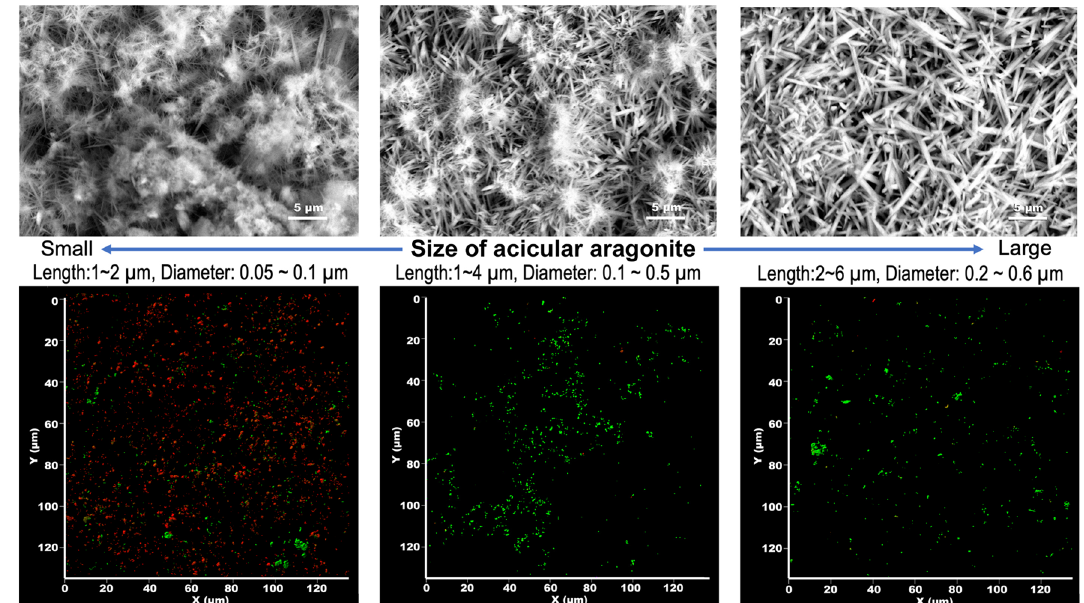
Figure 5. Relationship between the crystal size of acicular aragonite and bactericidal performance. Upper and Lower row shows the SEM image and the Confocal microscopy image of acicular aragonite-modified TiO 2 ceramic surface with increase of aragonite preparation time, respectively. Repeat time of circulation The size of acicular aragonite